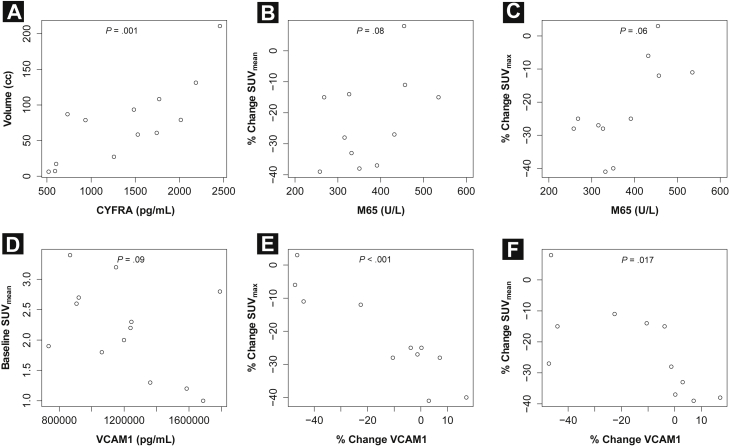
Correlation Between (A) Baseline Cytokeratin-19 Antigen (CYFRA) and the Volume of the Primary Tumor on Baseline [18]fluorothymidine (18FLT)-Positron Emission Tomography (PET) Computed Tomography; (B) Baseline VCAM-1 and Baseline 18FLT-PET Mean Standardized Uptake Value (SUVmean); (C) Baseline M65 and Early-Treatment Changes in 18FLT-PET Maximum Standardized Uptake Value (SUVmax); (D) and SUVmean; (E) Early-Treatment Changes in VCAM-1 (Baseline Compared With Blood Sample Taken on Day of 18FLT-PET) and Early-Treatment Changes in 18FLT-PET SUVmax; (F) Early-Treatment Changes in VCAM-1 (Baseline Compared With Blood Sample Taken on Day of 18FLT-PET) and Early-Treatment Changes in 18FLT-PET SUVmeanAbbreviation: VCAM-1 = vascular cell adhesion molecule 1.